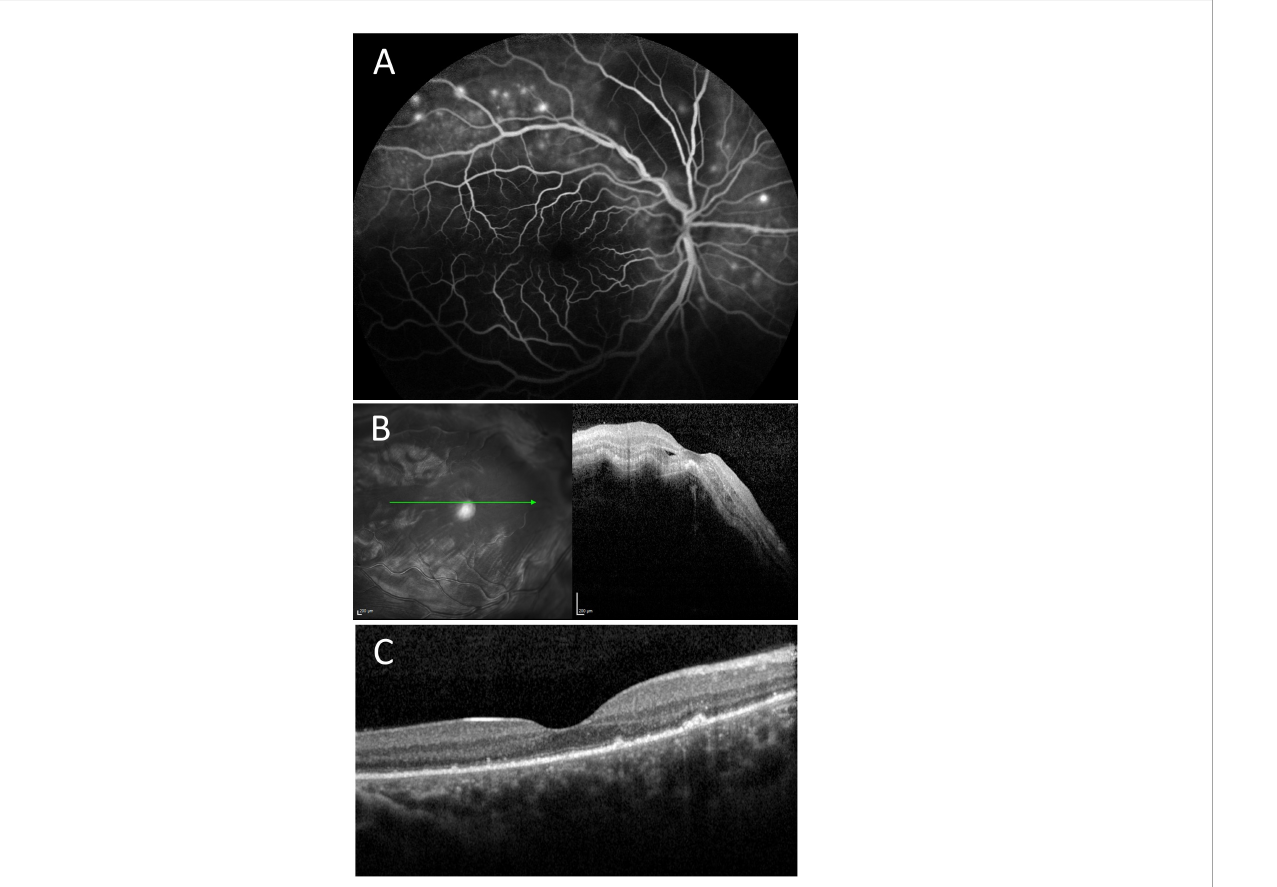
FIGURE 6 Case number 12. Multimodal imaging of a 37-year-old woman with obstetric and thrombotic antiphospholipid syndrome, and clinical signs cutaneous- articular lupus associated with pulmonary embolism quiet on oral 7.5mg of prednisone. She initially complained of decreased visual acuity of the left eye following a period of severe anxiety. (A) FA of the right eye shows multiple pinpoint areas of staining and a central hypo fl uorescent area compatible with a serous detachment. (B) OCT show thickened serous detachment compatible with posterior scleritis. Systemic mycophenolate mofetil allowed for the control of ophthalmic and systemic symptoms with resolution of serous detachment on SD-OCT (C)